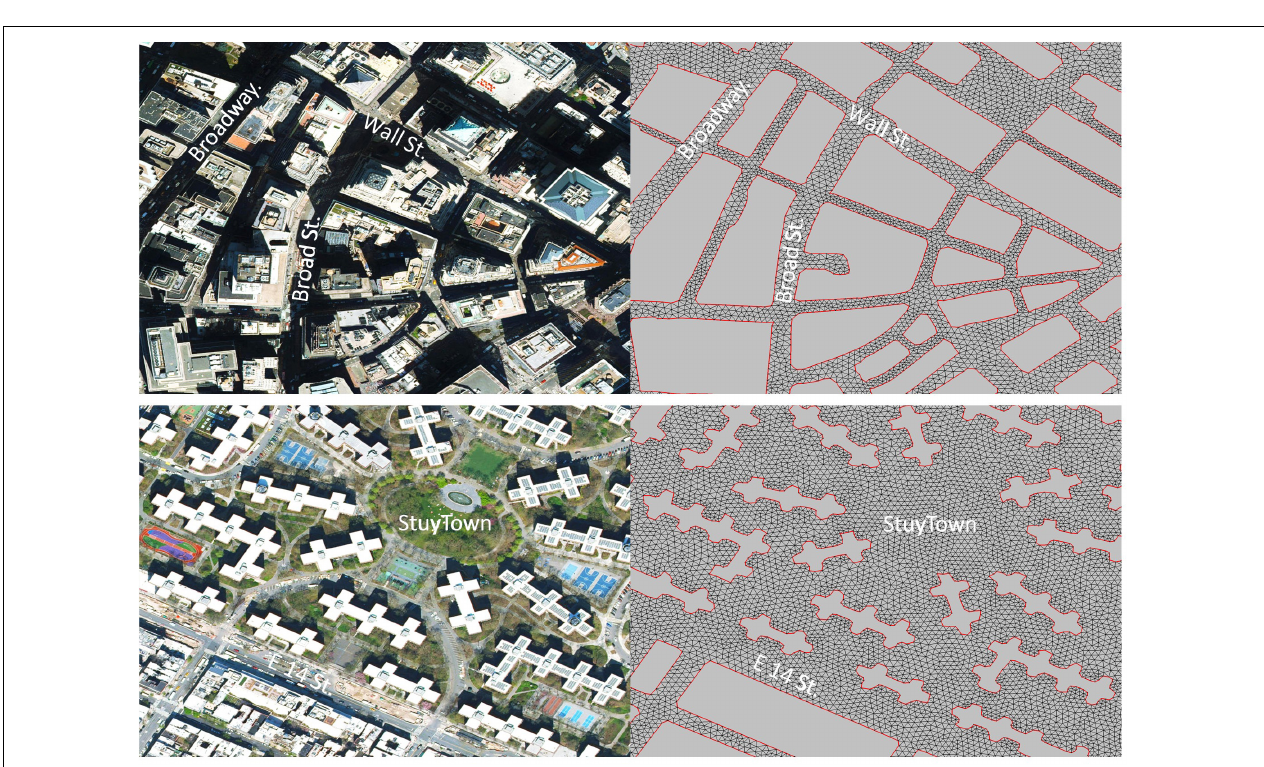
FIGURE 2 | Computational mesh in Manhattan has a resolution of between 3 and 8 m and resolves urban features such as buildings and roads (top panel: a financial district in Lower Manhattan. bottom panel: a residential neighborhood on the east side of Manhattan, see Figure 3 for the locations). Left panels are based on World Imagery from Surface-water Modeling System, SMS, software (https://www.aquaveo.com/).